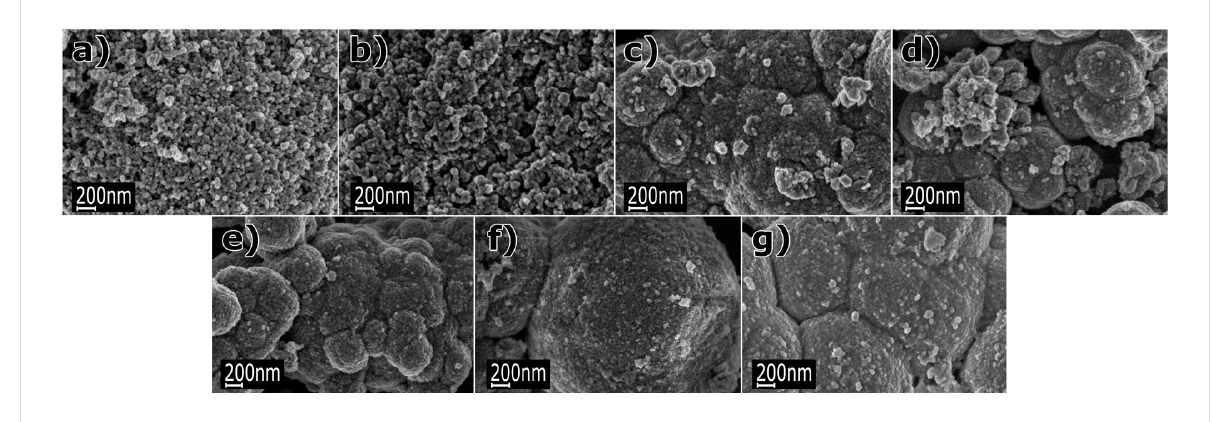
Figure 4: SEM images of agglomerates and conglomerates of Zn 1 − x Mn x O NPs with dopant concentrations of: a) 0 mol %, b) 1 mol %, c) 5 mol %, d) 10 mol %, e) 15 mol %, f) 20 mol % and g) 25 mol %.